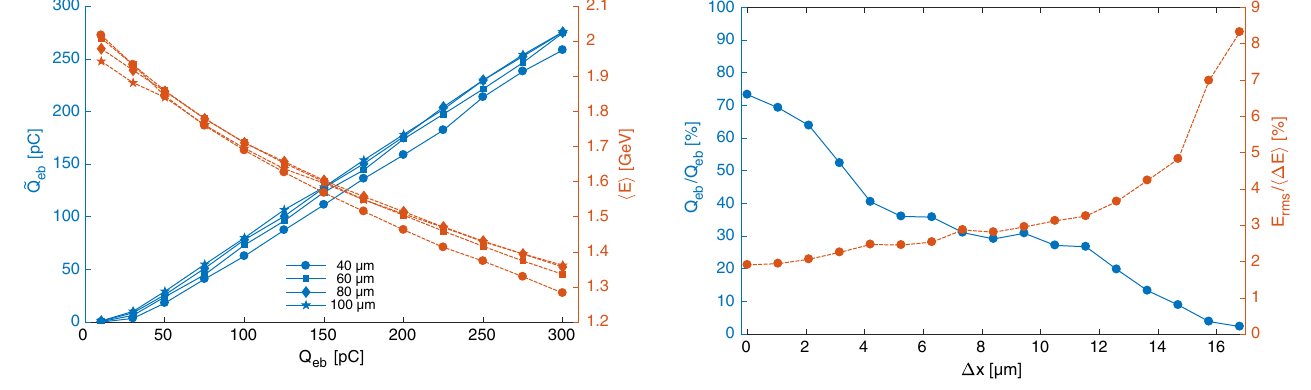
FIG. 8. Witness beam charge with emittance preserved, symbols, lines), as a function of initial beam charge, and final energy (red symbols, dashed lines), after 4 m of plasma and with ¼ 2 μ m. an initial emittance ϵ N ; 0